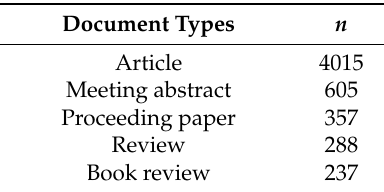
Table 4. Type of Table 4. Type of document.